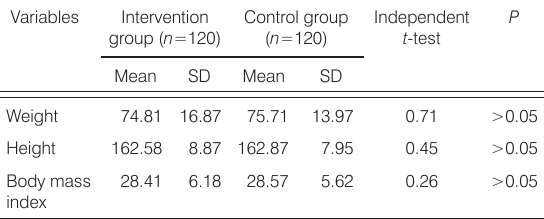
Table 2. Mean score of anthropometric measurements of the studied